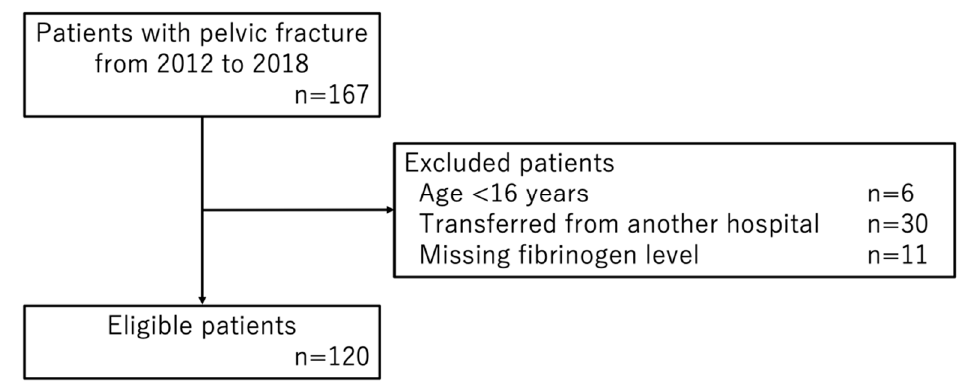
Figure 1. Patient Figure 1. Patient flow. Table 1. Patient characteristics of patients with pelvic fracture.